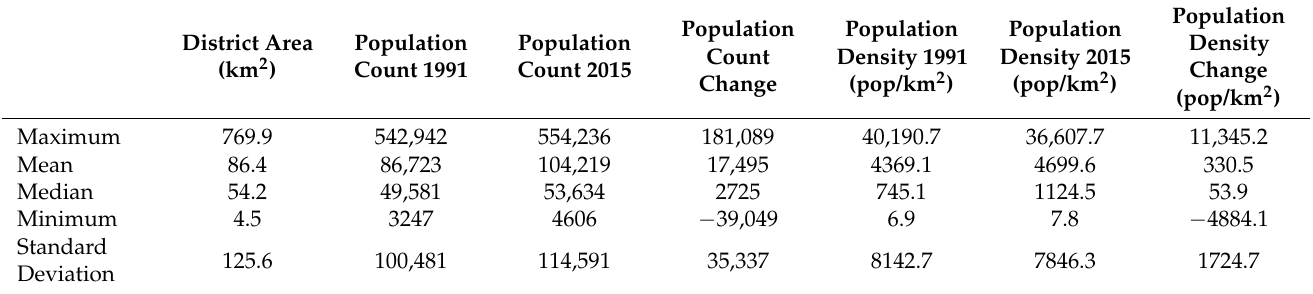
Table 3. Descriptive statistics of registered population, population density, and population change at the district level.